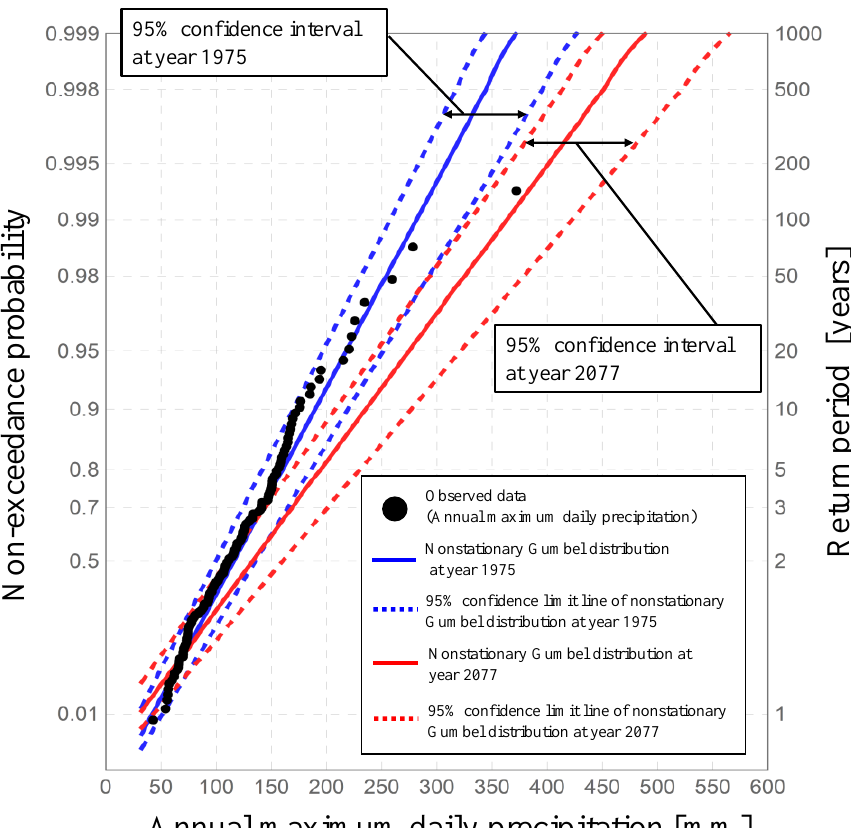
Figure 9. Observed data of annual maximum daily precipitation over 142 years (from 1876 to 2017) at the Meteorological Agency ground observation station Tokyo, with a non-stationary Gumbel distribution fitted to these values (blue solid line: non-stationary Gumbel distribution for 1975; red solid line, non-stationary Gumbel distribution for 2077). The 95% confidence intervals of both non-stationary Gumbel distributions are based on the probability limit method test. n is the total number of observed data. Note that the Hazen Equation was used for the plotting position equation.